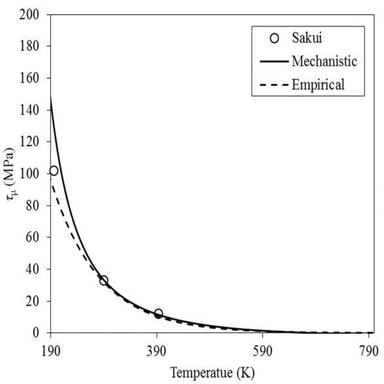
Temperature dependence of rate independent thermal stress: comparison experimental results from Sakui and Sakai with mechanistic and empirical thermal stress models.